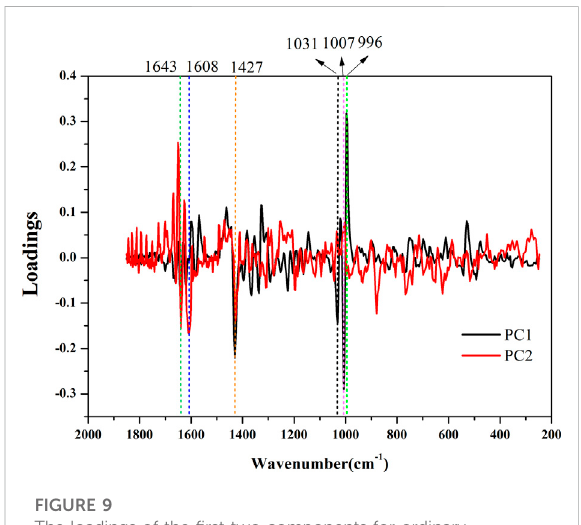
FIGURE 9 The loadings of the fi rst two components for ordinary principal component analysis (PCA). The Raman bands at 1643 – 1 , 1608 – 1 , 1427 – 1 , 1031 – 1 , 1007 – 1 , and 996 cm − 1 showing large intragroup